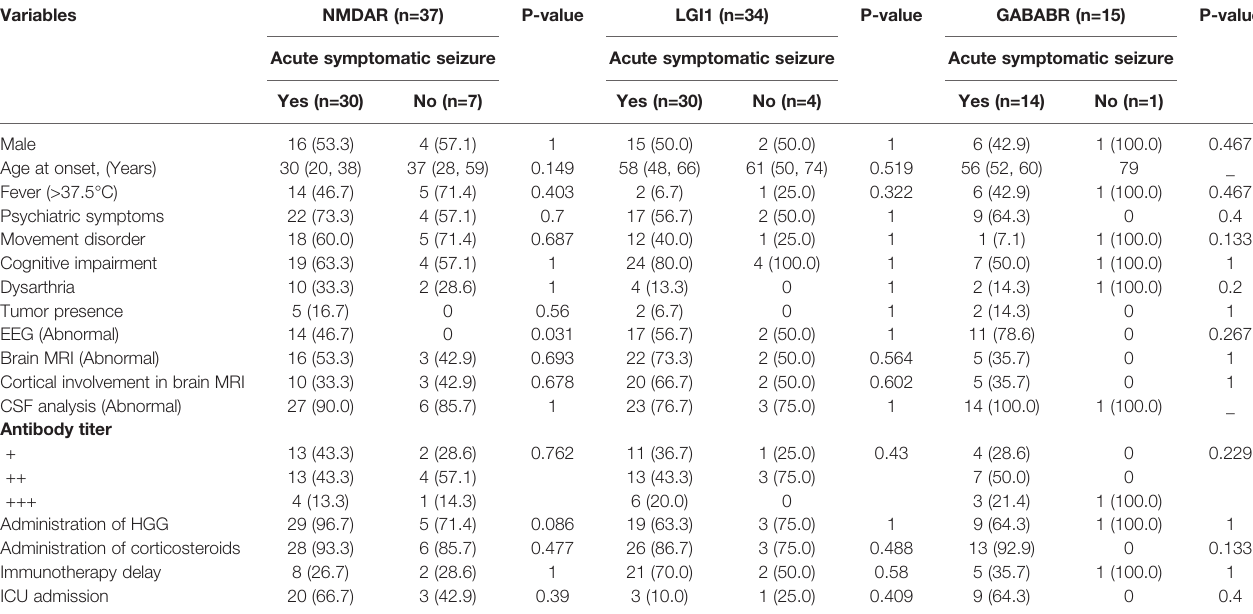
TABLE 4 | Univariate analysis of factors associated with acute symptomatic seizures in patients with anti-NMDAR, anti-LGI1, and anti-GABABR encephalitis. Variables NMDAR (n=37)